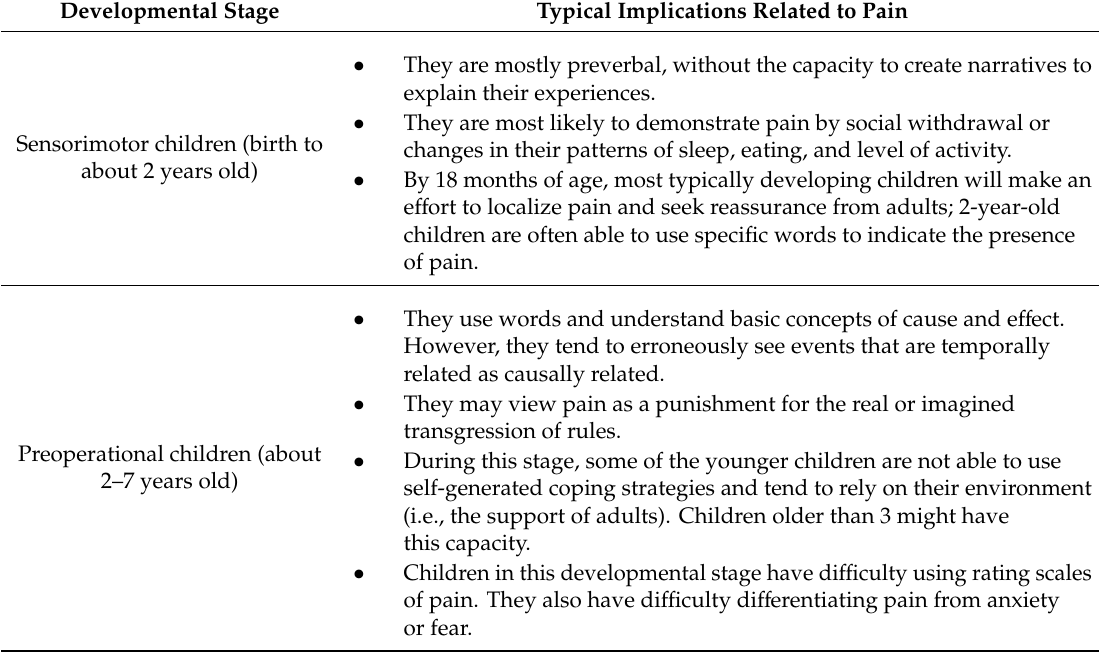
Table 1. Piagetian Stages of Cognitive Development and the Experience of Pain